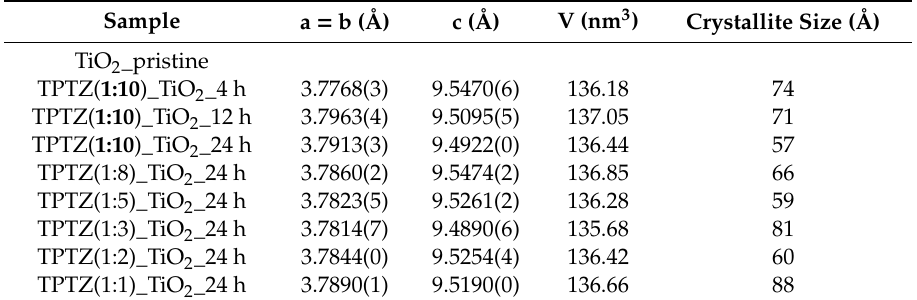
Table 2. Structurally refined data from the XRD measurements of the TPTZ_TiO 2 microparticles.